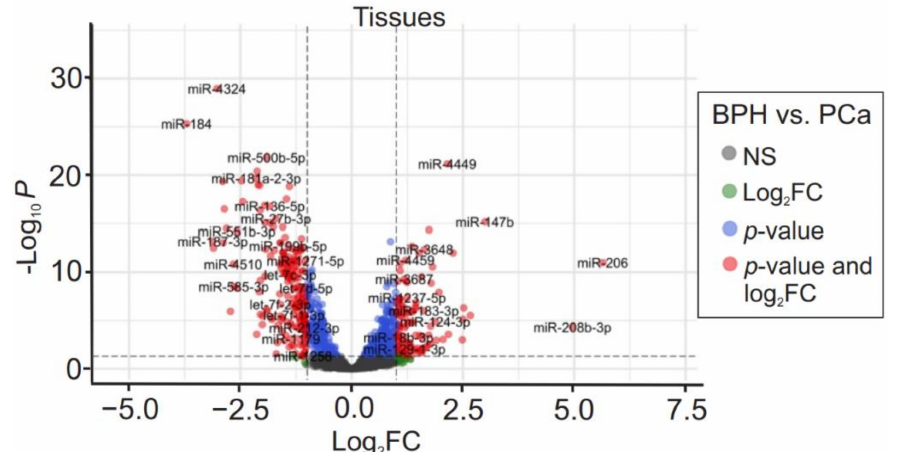
Figure 3. Specific microRNAs (miRs) detected in PCa and BPH tissues. The volcano plot of DE miRs in tissue samples of BPH vs. PCa is based on p -value and log 2 FC at an α level of 0.05 and absolute log 2 FC cutoff of 1. Colored dots correspond to each miR whose expression differences were significant based on both p -value and log 2 FC values (red dots), only p -value (blue dots), only log 2 FC (green dots), or not significant (grey dots). Down-regulated miRs are on the left side and up-regulated genes are on the right side (total variables = 2083).